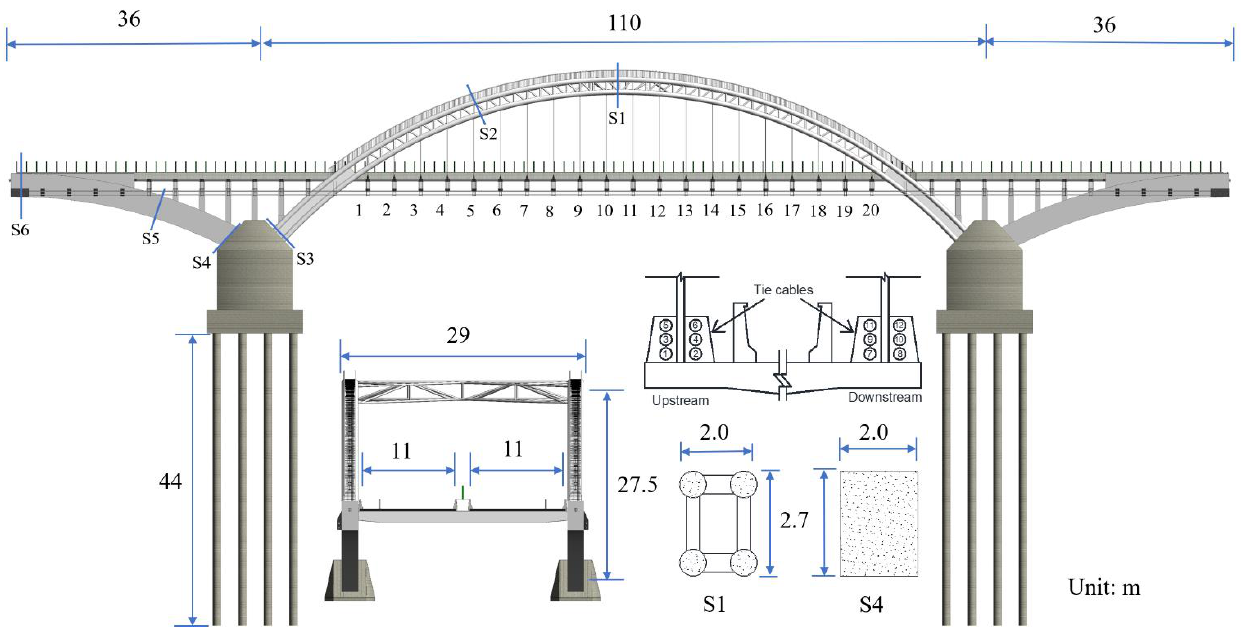
Figure 1. The layout of the third Lingjiang bridge.